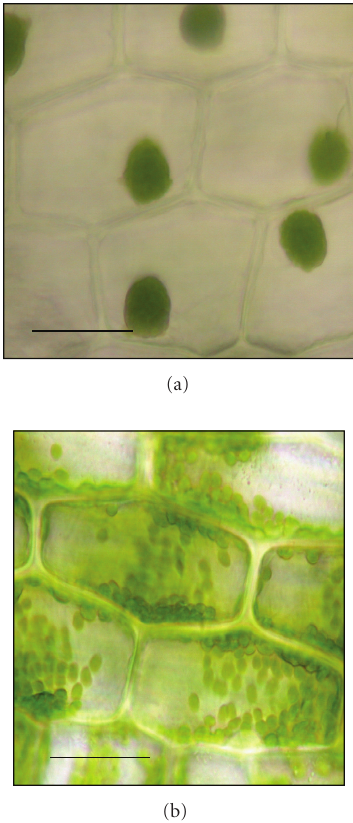
Figure 3: Light-microscopic photographs of epidermal cells of Halophila stipulacea during midday (at 850 µ molphotonsm − 2 s − 1 ) grown for 14 days under a control filter (a) and under a UV filter (b). Black bars represent 10 µ